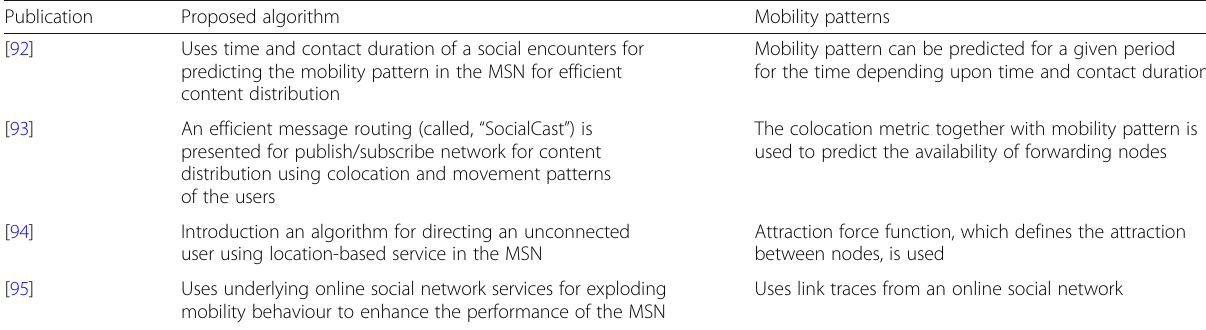
Proposed algorithm Mobility